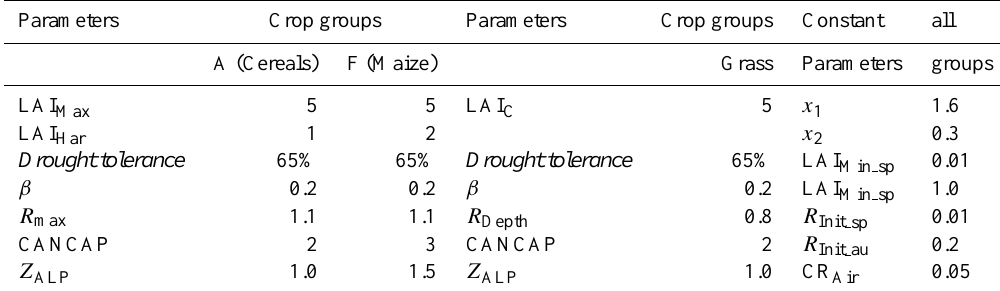
Table 5. Crop parameters in the FOOTPRINT inference system used in this study. Parameters Crop groups Parameters Crop groups Constant all A (Cereals) F (Maize) Grass Parameters groups LAI Max 5 5 LAI C 5 x 1 1.6 LAI Har 1 2 x 2 0.3 Drought tolerance 65% 65% Drought tolerance 65% LAI Min sp 0.01 β 0.2 R Init sp 0.01 CANCAP 2 3 CANCAP R Init